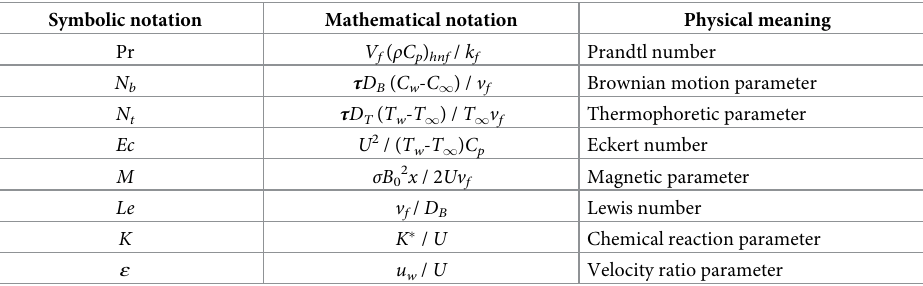
Table 1. Information of emerging